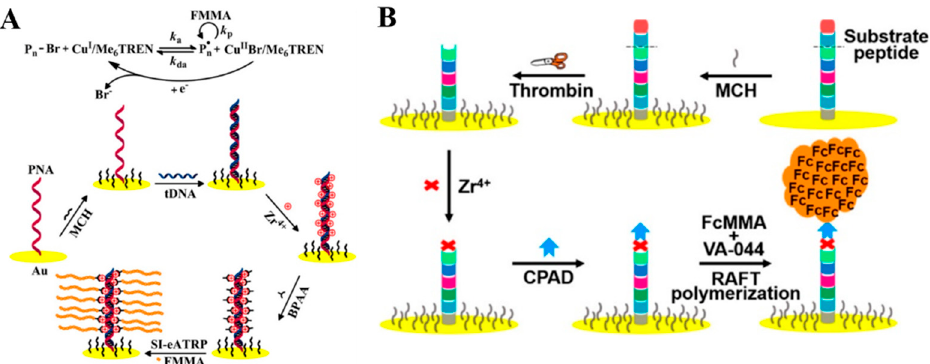
Figure 11. ( A ) Schematic representation of the principle of the dnGOPs-based electrochemical detection of DNA [89]. Copyright 2017 American Chemical Society. ( B ) Schematic representation of “signal-on” electrochemical biosensing